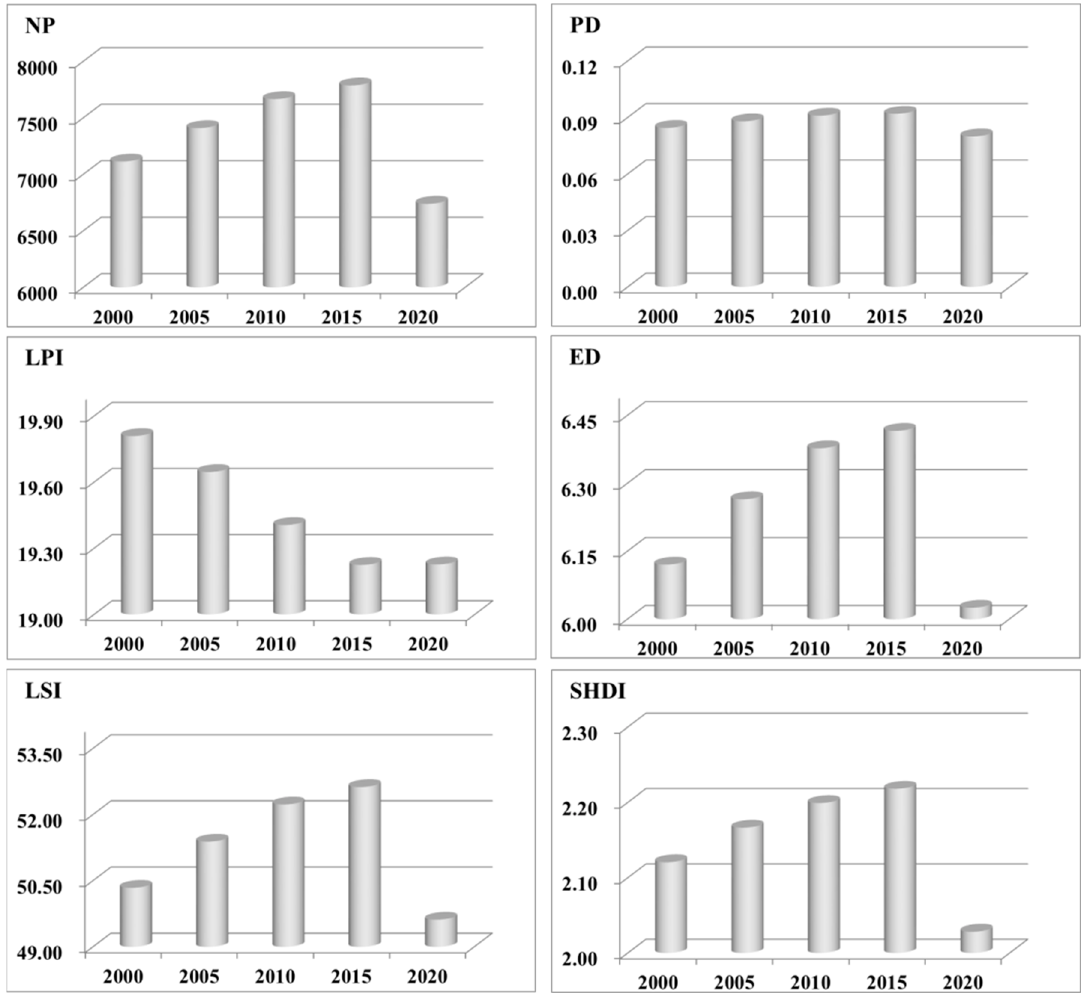
Figure 3. The change of landscape pattern index of green space in coastal cities of southeast China over the past 20 years. NP, PD, LPI, ED, LSI and SHDI are number of patches, patch density, the largest patch index, edge density, landscape shape Index and Shannon’s diversity index, respectively.